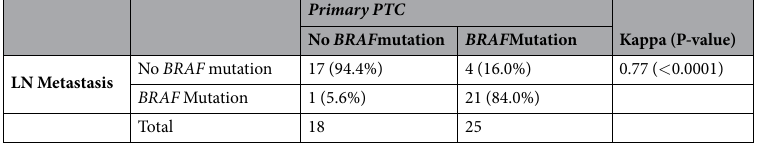
Table 6. Agreement in BRAF mutation in between primary PTC tumor and the corresponding metastatic lymph nodes. Concordance in BRAF mutation between primary PTC and the corresponding metastatic lymph